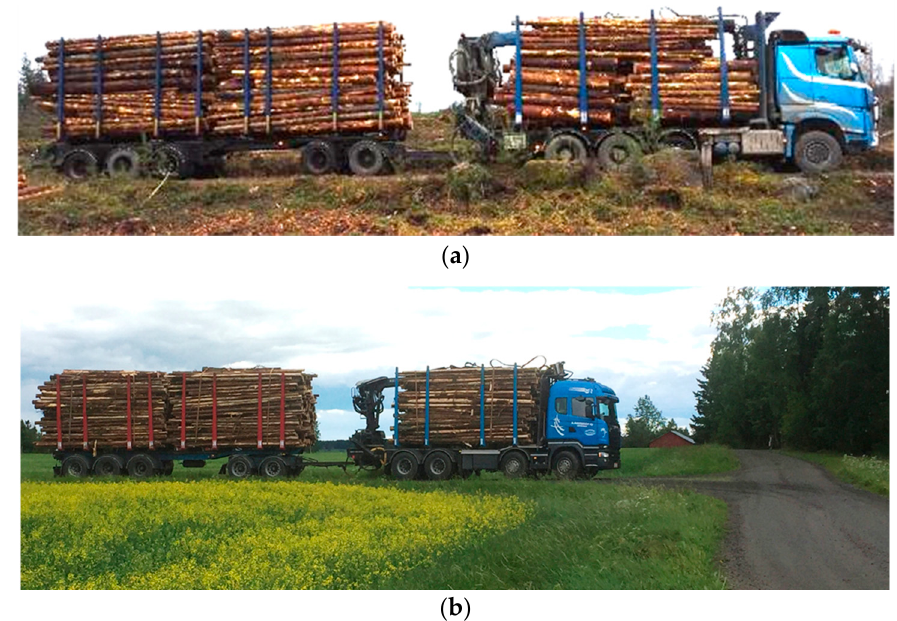
Figure 3. A transportation vehicle (76 t with crane) delivers timber from forest to mills on forest road conditions: ( a ) mass-constraint payload with short cut-to-length logs on truck load, ( b ) fully loaded vehicle with long logs on truck load (photos: Joonas Hyypiä (a) and Kalle Kärhä (b)).